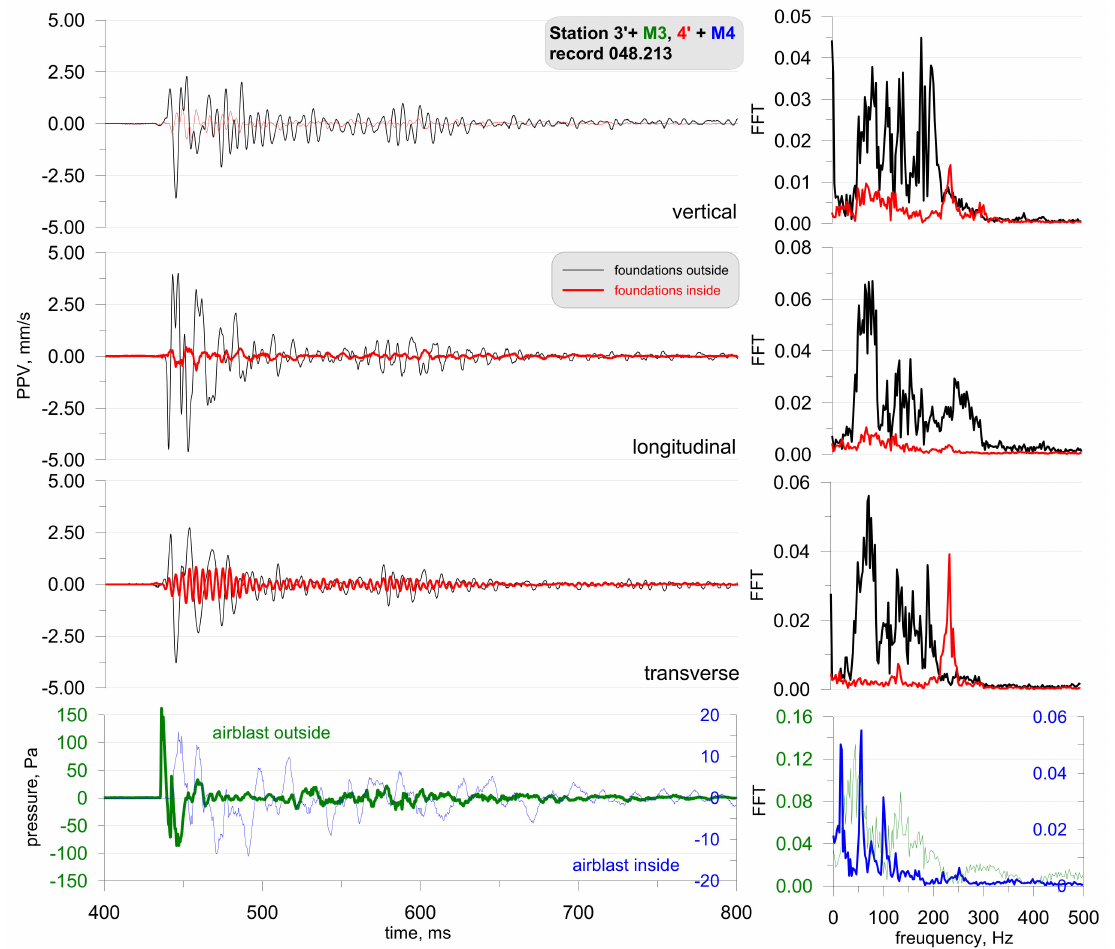
Figure 20. Foundation vibration seismogram (three directional components) and recording of airblast wave pressure combined with the analysis of the FFT-Station 3 and 4—explosive charge on the